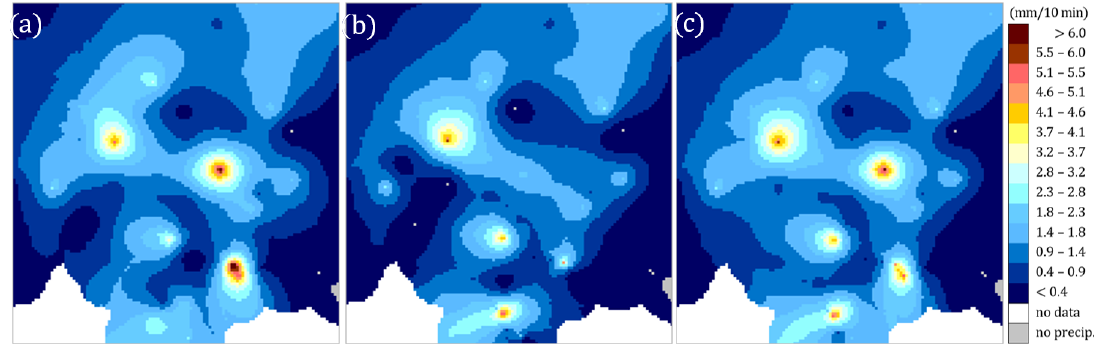
Figure 6. Spatially interpolated rain station data obtained from (a) unheated and (b) heated sensors, as well as (c) after quality control (considered optimal). Data from 5 August 2021 at 17:40UTC for a fragment of the Polish domain (240km × 250km).